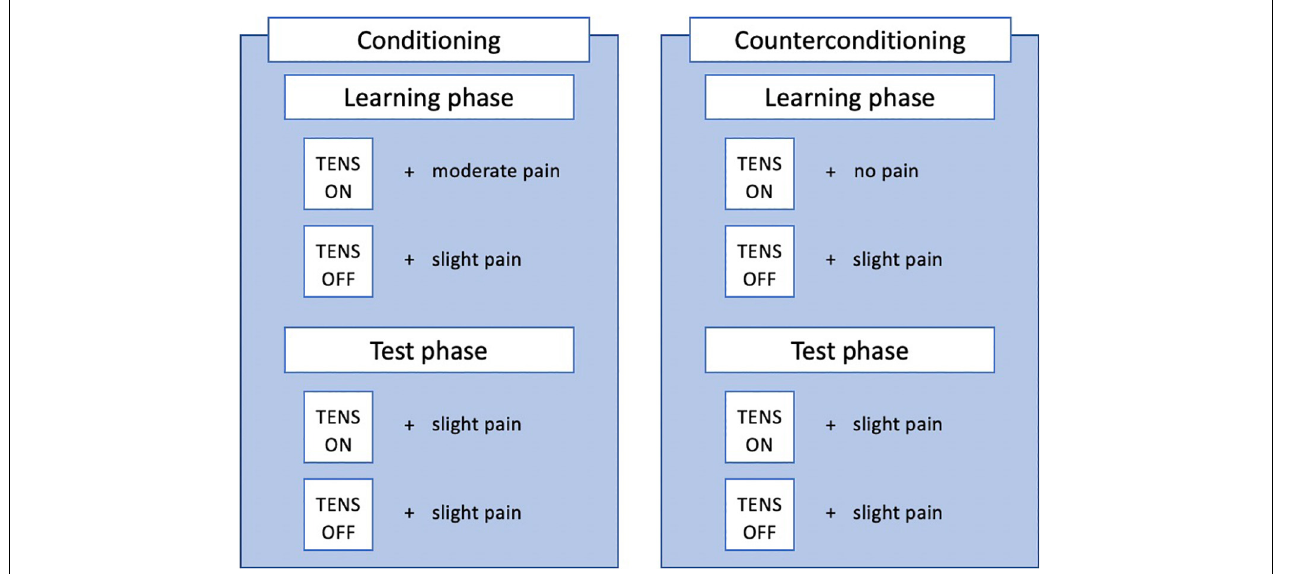
FIGURE 2 | Procedures used for conditioning and